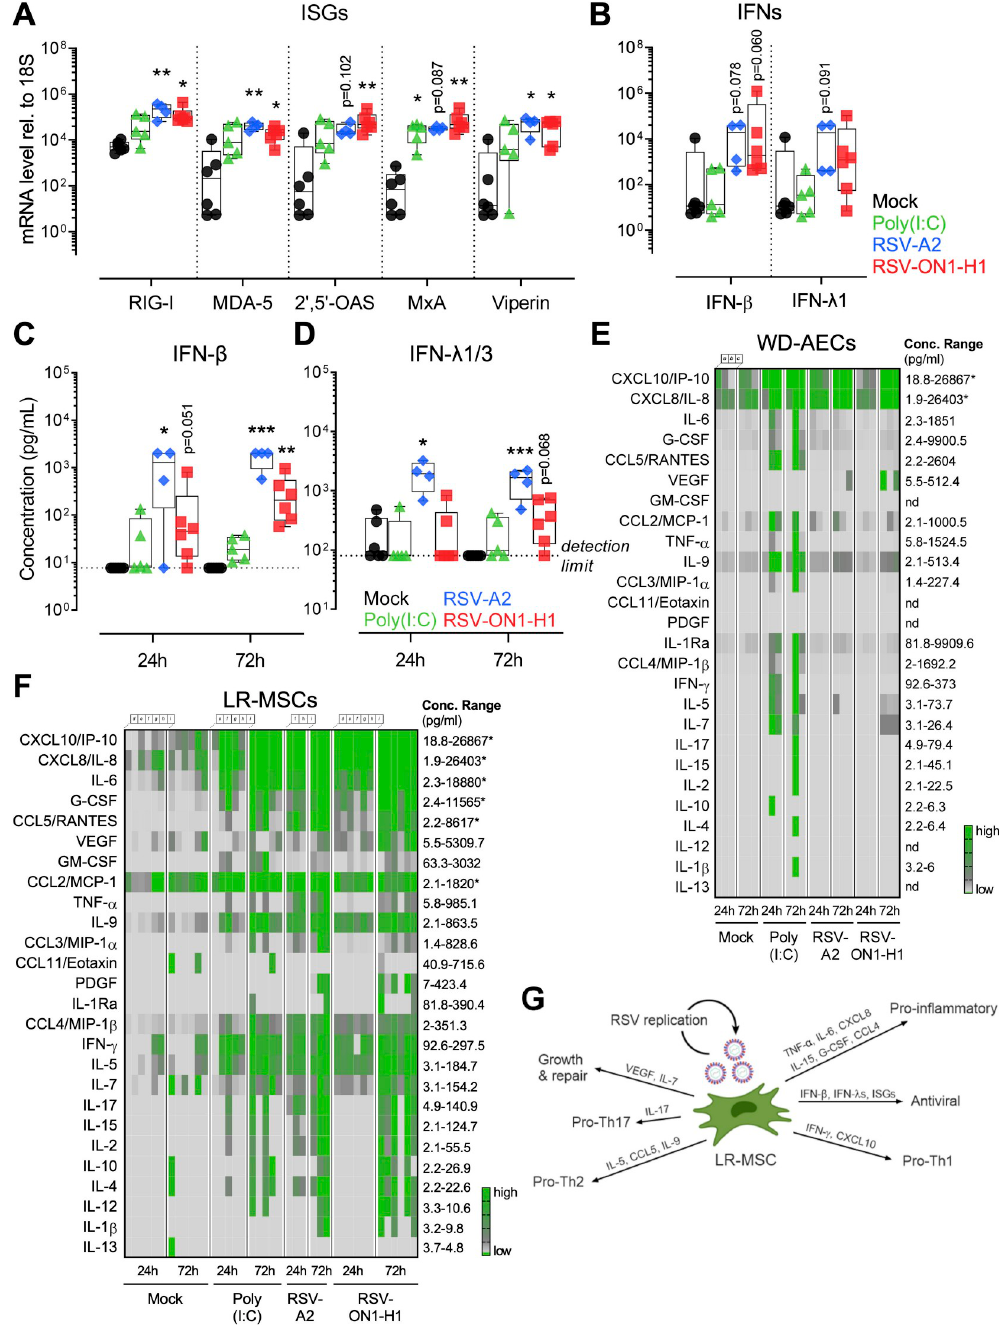
Fig 2. RSV infection is altering the immune properties of LR-MSCs. (A, B) mRNA levels of selected ISGs (A) and IFNs (B) in LR-MSCs treated with mock control, poly(I:C) 10 μ g/ml, RSV-A2, or RSV-ON1-H1 for 24 h at 1 PFU/cell. Boxplots indicate the median value (centerline) and interquartile ranges (box edges), with whiskers extending to the lowest and the highest values. Each symbol represents an individual donor (mock, n = 6; poly(I:C), n = 5; RSV-A2, n = 4; RSV-ON1-H1, n = 6). The data were compared with the Kruskal–Wallis test followed by Dunn’s post hoc test. � p < 0.05, �� p < 0.01. (C, D) IFN- β (C) and IFN- λ 1/3 (D) protein levels in supernatants of LR-MSCs treated with mock control, poly(I:C) 10 μ g/ml, RSV-A2, or RSV-ON1-H1 for 24 h and 72 h at 1 PFU/cell. Boxplots indicate median value (centerline) and interquartile ranges (box edges), with whiskers extending to the lowest and the highest values. Each symbol represents an individual donor (mock, n = 6; poly(I:C), n = 5; RSV-A2, n = 4; RSV-ON1-H1, n = 6). A Kruskal–Wallis test followed by a Dunn’s post hoc test was applied to compare the different groups. � p < 0.05, �� p < 0.01, ��� p < 0.001. The detection limits of the assays